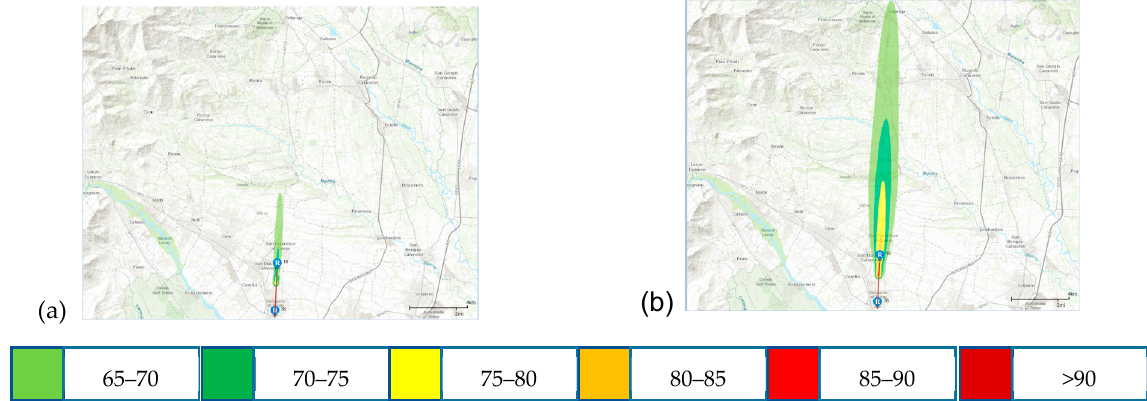
Figure 46. Graphical representation of equal loudness contours for the conventional ( a ) and hybrid ( b ) configurations, in terms of L AE (dB-A), for a standard runway-18 landing.